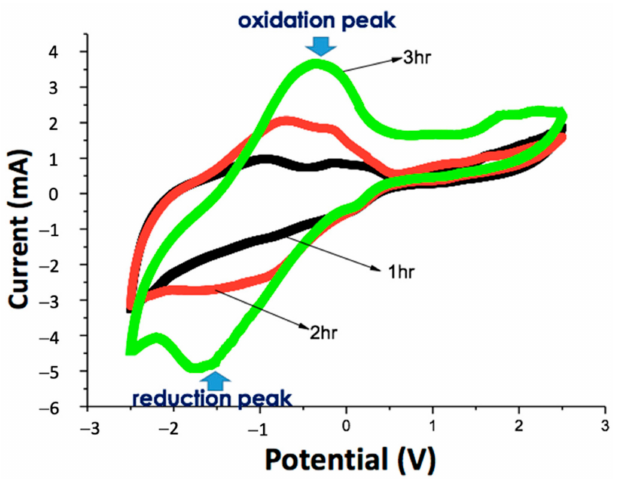
Figure 2. Cyclic voltammetry of the V 2 O 5 thin films as ion storage layer of the electrochromic